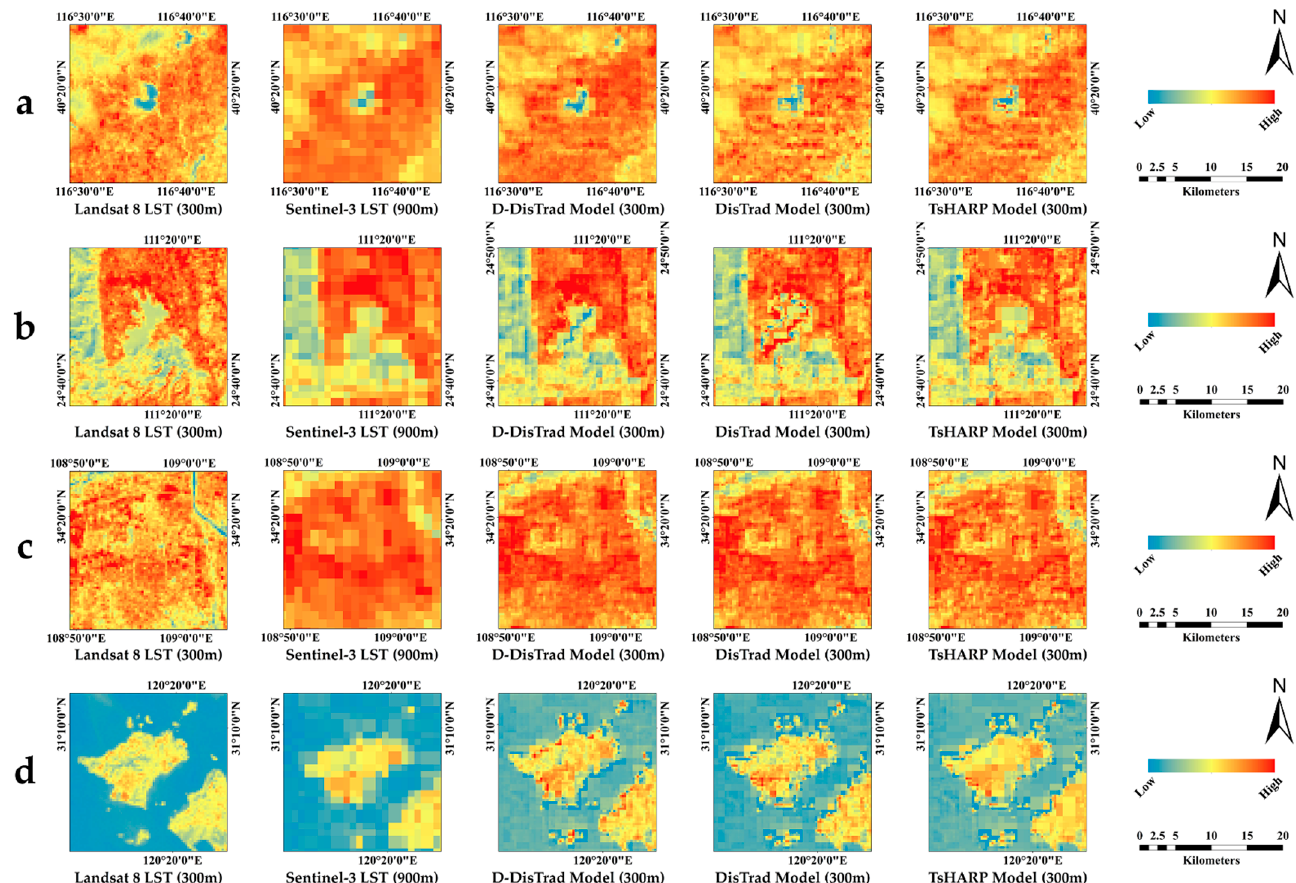
Figure 4. Each line goes from left to right, showing Landsat 8 LST, SLSTR LST, D-DisTrad LST, DisTrad LST, and TsHARP LST data. Areas with noticeable changes for the 4 sites: ( a ) site 1; ( b ) site 2; ( c ) site 3; ( d ) site 4.